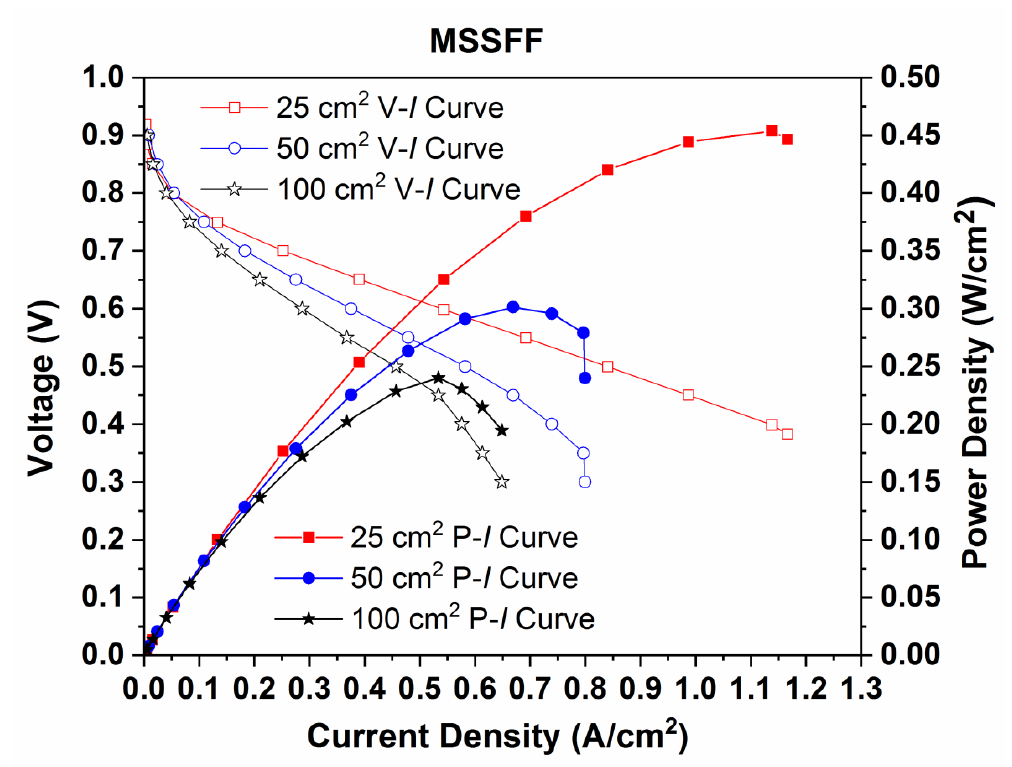
Figure 12. Performance (P–I) curves and Polarization (V–I) curves of PEMFCs with reaction areas of 25, 50 and 100 cm 2 employing MSSFF.